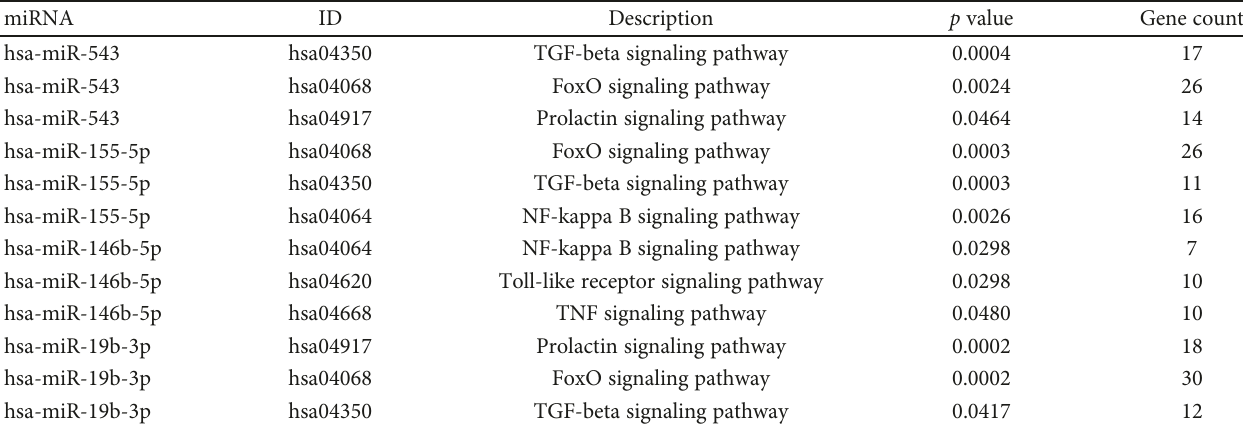
Table 2: Immune-related pathways predicted to be targeted by individual